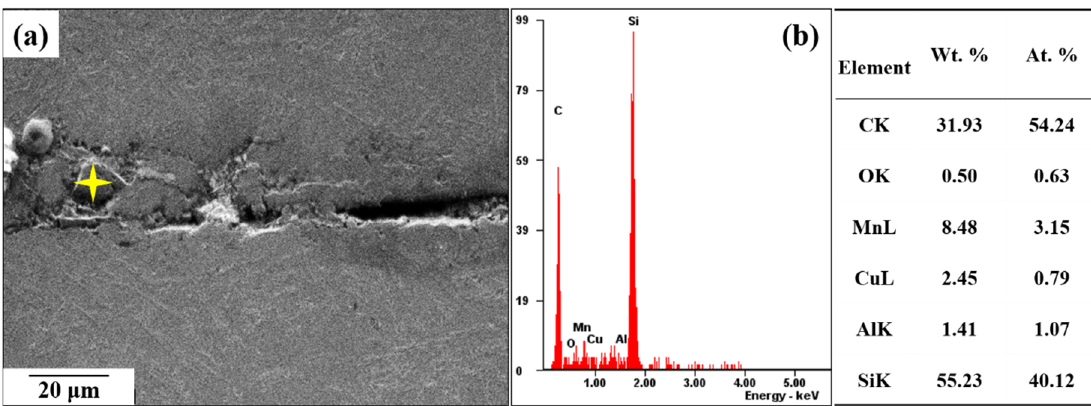
Figure 4. ( a ) SEM images of non-metallic inclusion at interface of Al3003 and Al4004 boundary in sampling position #3 of as-received duo-casted Al3003/Al4004, and ( b ) Energy Dispersed X-ray point (EDS) pattern and composition of the inclusion.